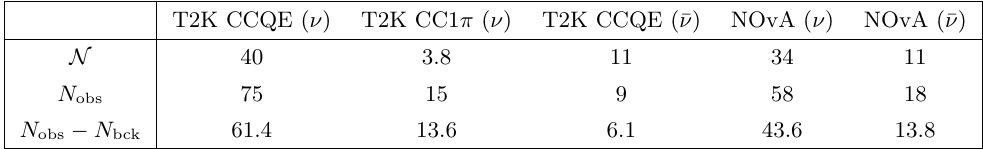
Table 2 . Normalization coe(cid:14)cients N (cid:23) and N (cid:22) (cid:23) for eqs. (3.8) and (3.9) for approximations used to qualitatively describe the various appearance event samples used in our analysis for T2K and NOvA. We also give the observed number of events, as well as the corresponding background subtracted event numbers, as reported in refs. [45,